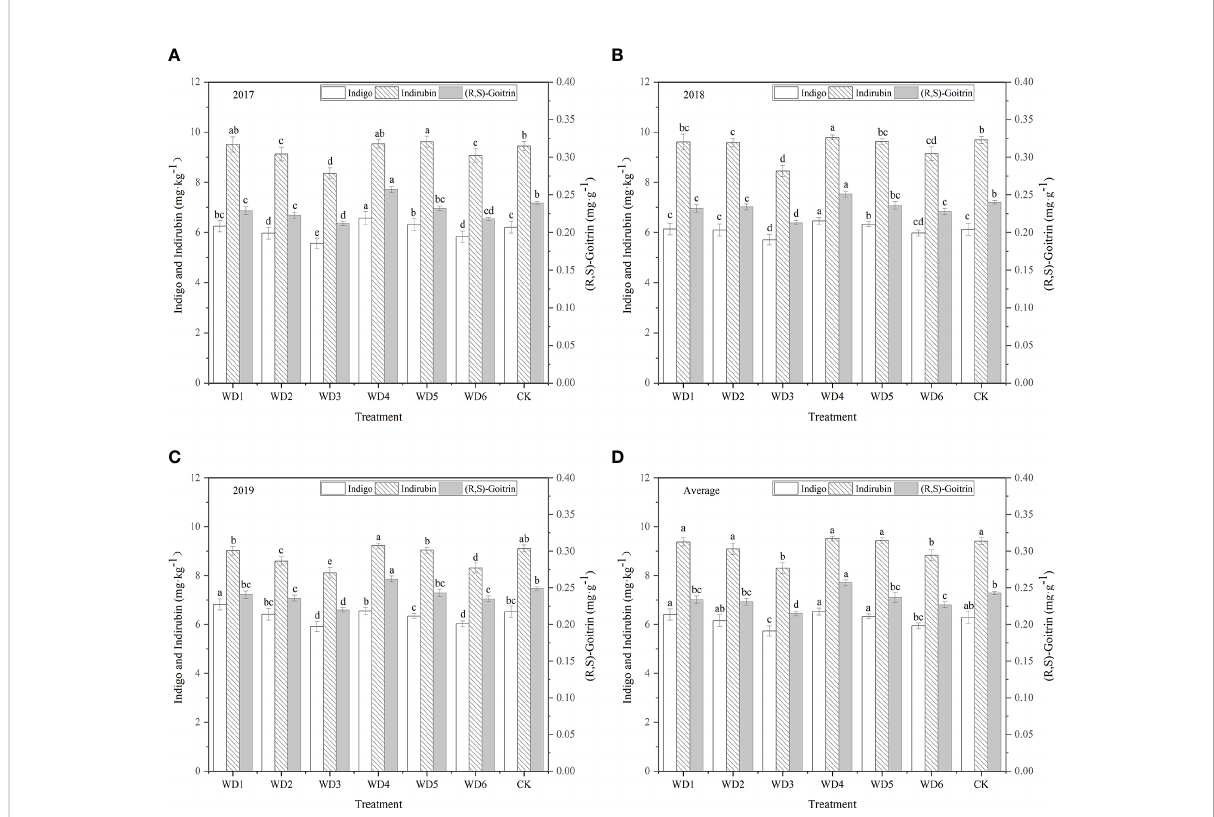
FIGURE 11 Indigo, indirubin, and (R,S)-goitrin contents of I. indigotica plants in different water de fi cit treatments. (A – D) describe the indigo, indirubin, and (R,S)-goitrin contents in 2017, 2018, 2019, and the average of these three years, respectively. Different lowercase letters in the same column indicate signi fi cant differences ( P < 0.05). Data were presented as mean ± SE (n =